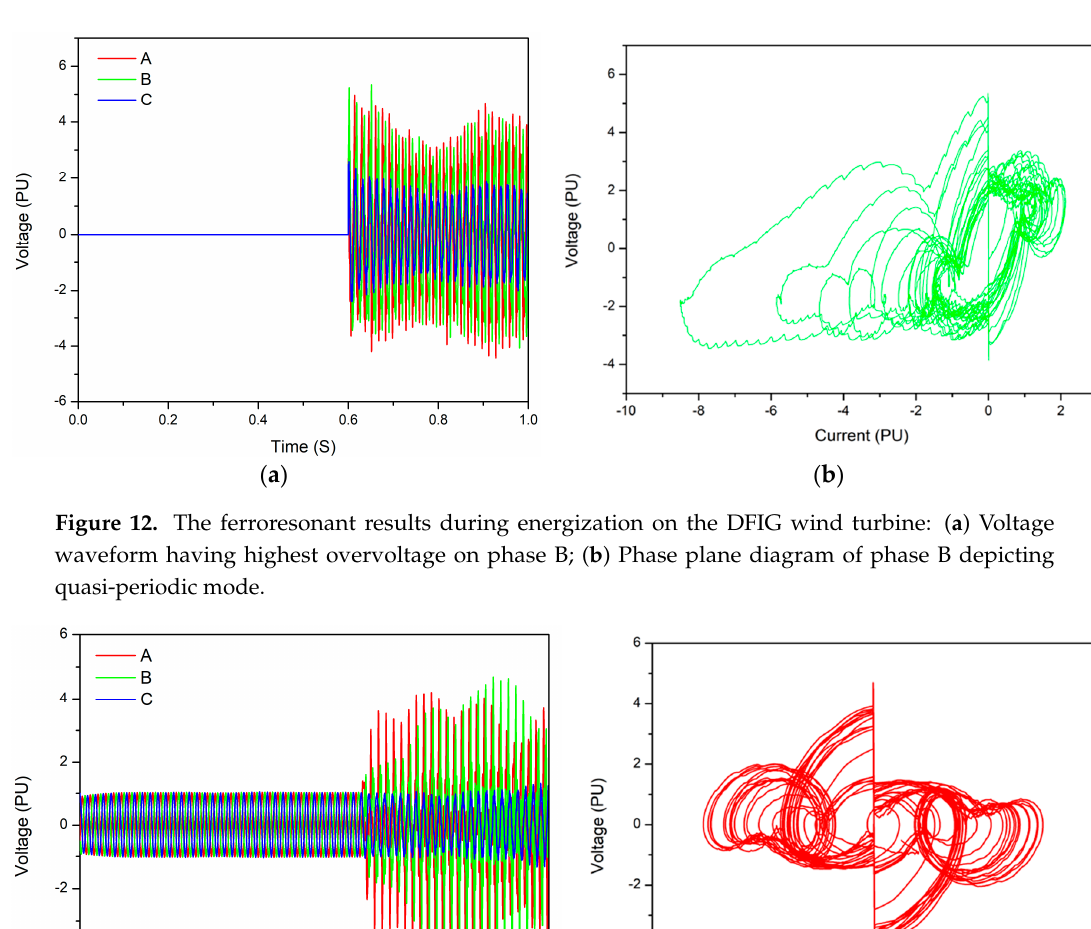
Figure 11. The ferroresonant results during de ‐ energization at 0.6 secs on the WRIG wind turbine: ( a ) Voltage waveform of phase A, B and C with highest overvoltage on phase B; ( b ) Phase plane diagram of phase B.